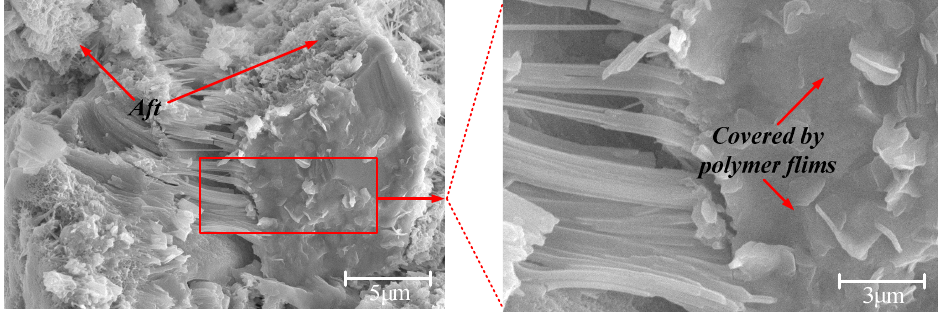
Figure 13. SEM image of cement mortar with 2.0% PVA content at 28 days.